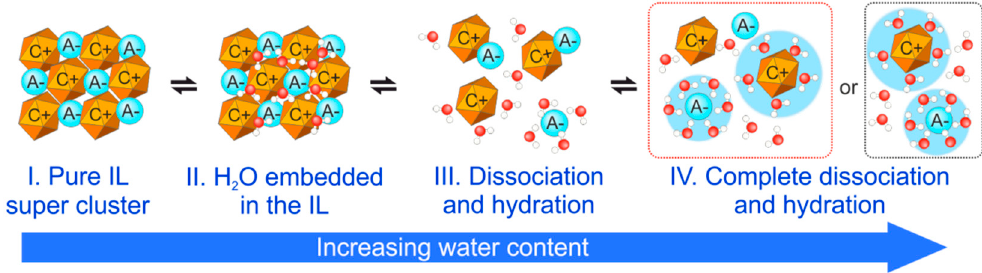
Figure 3. Schematic illustration of the mechanism of the intermixing between water and an ionic liquid. The ionic liquid is displayed in yellow (cations) and blue (anions) and the water in red (oxygen) and white (hydrogen). Adapted from Ma et al. [44].